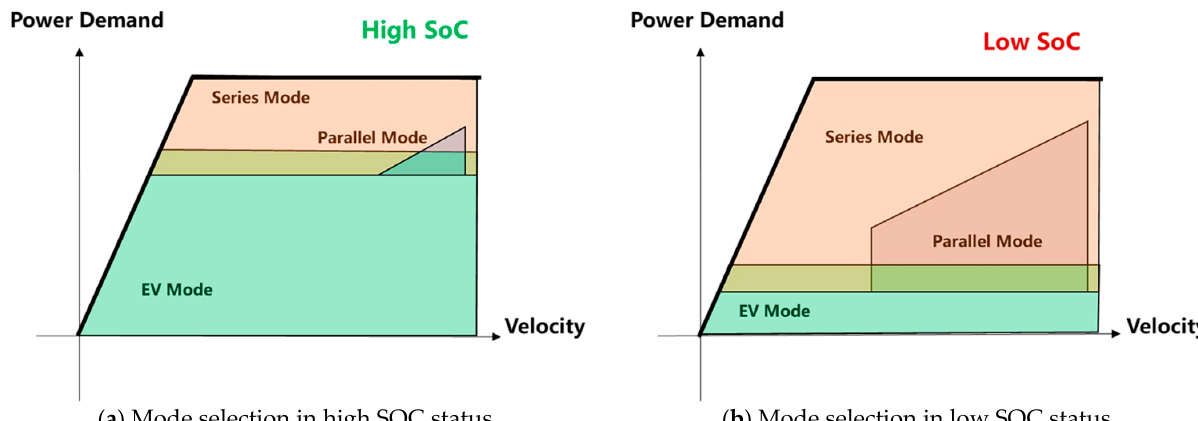
Figure 4. Basic strategy logic of DMi energy management.